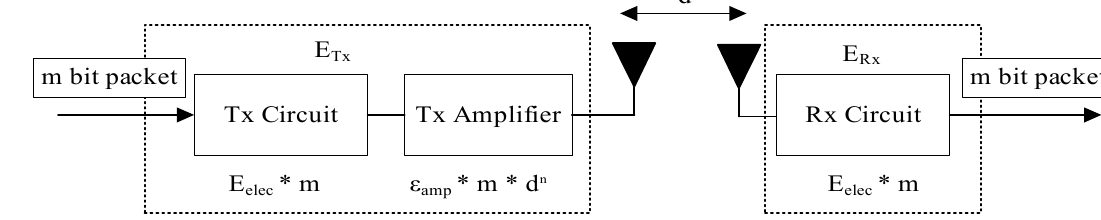
Figure 3. Radio energy dissipation model.